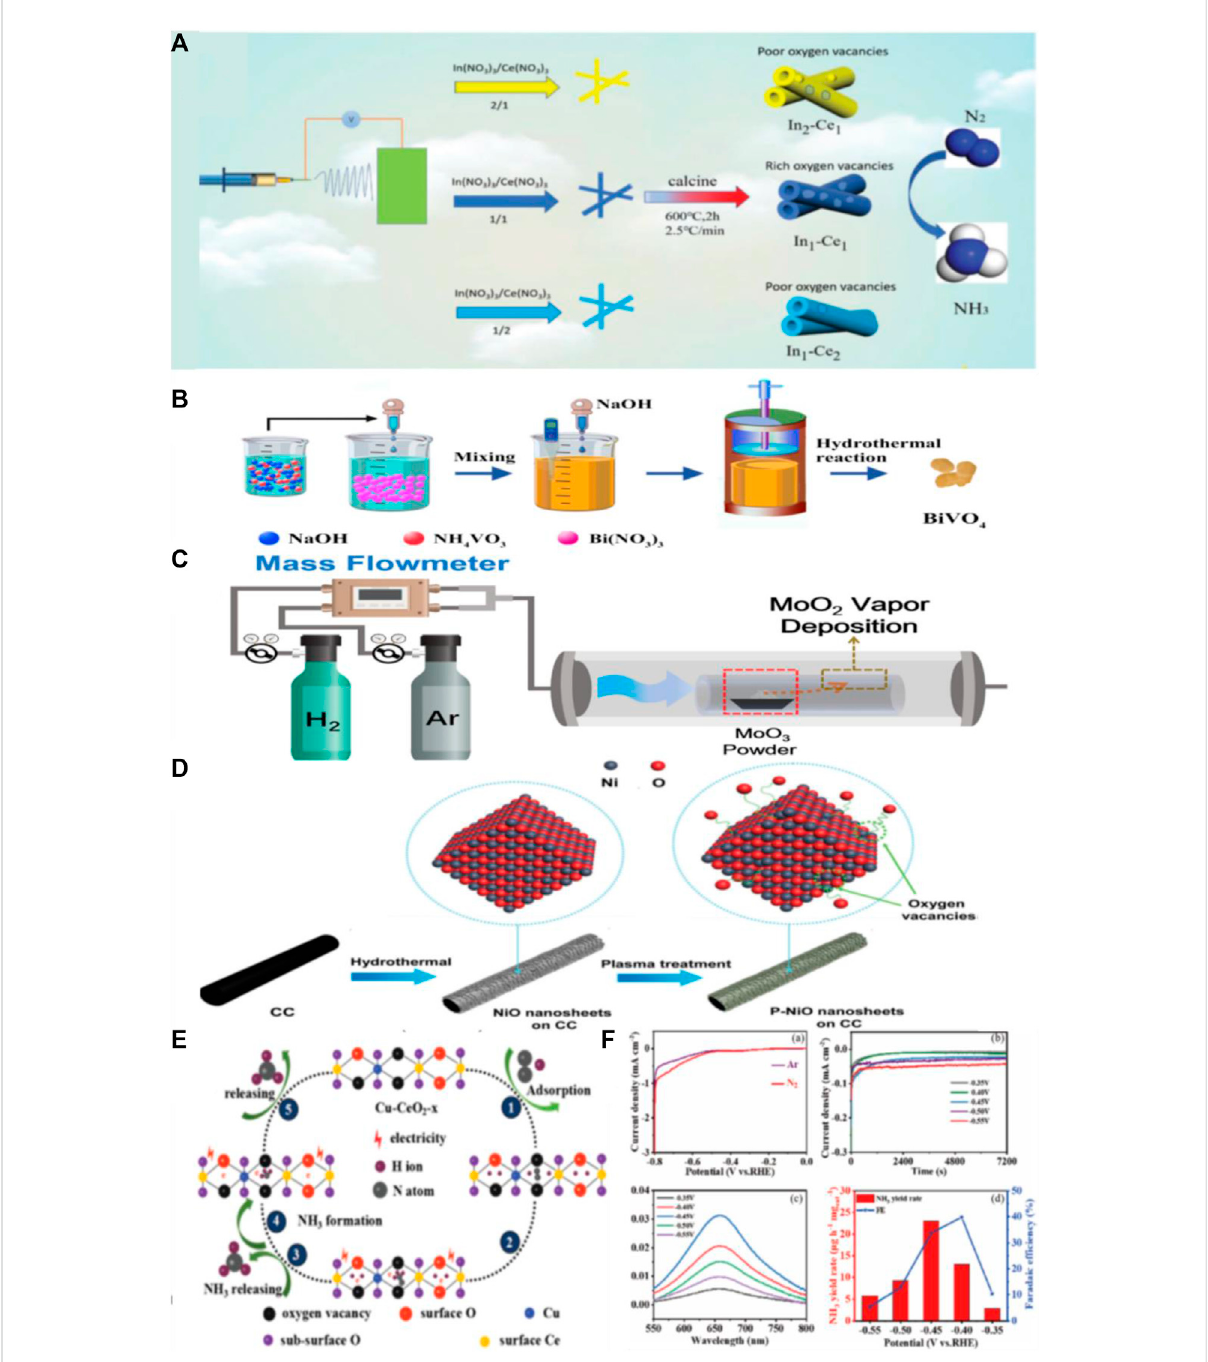
FIGURE 2 (A) The schematic diagram of the catalyst preparation and the illustration of the NRR on VO rich In 2 O 3-x /CeO 2-y . (Wang et al., 2020) with permission from 2020 Royal Society of Chemistry. (B) Schematic illustration of the preparation of BiVO 4 by hydrothermal method. (Yao et al., 2019) with permission from 2018 WILEY-VCH Verlag GmbH and Co. KGaA, Weinheim. (C) Schematic of the preparation of MoO 2 nanosheets. (Zhang G et al., 2019) with permission from Copyright 2019 Elsevier Ltd. (D) Schematic illustration of the synthesis process of P – NiO/CC. (Wang Y. et al., 2019) with permission from Copyright 2020 Royal Society of Chemistry. (E) The proposed NRR pathway for the NH 3 synthesis on the Cu-CeO 2 - 3.9 catalyst. (Zhang S etal., 2019)with permission from Copyright2019 RoyalSociety of Chemistry. (F) NRRperformance of P-KNO after electrolysis at different potentials. (Fan et al., 2022) with permission from Copyright 2022 Royal Society of